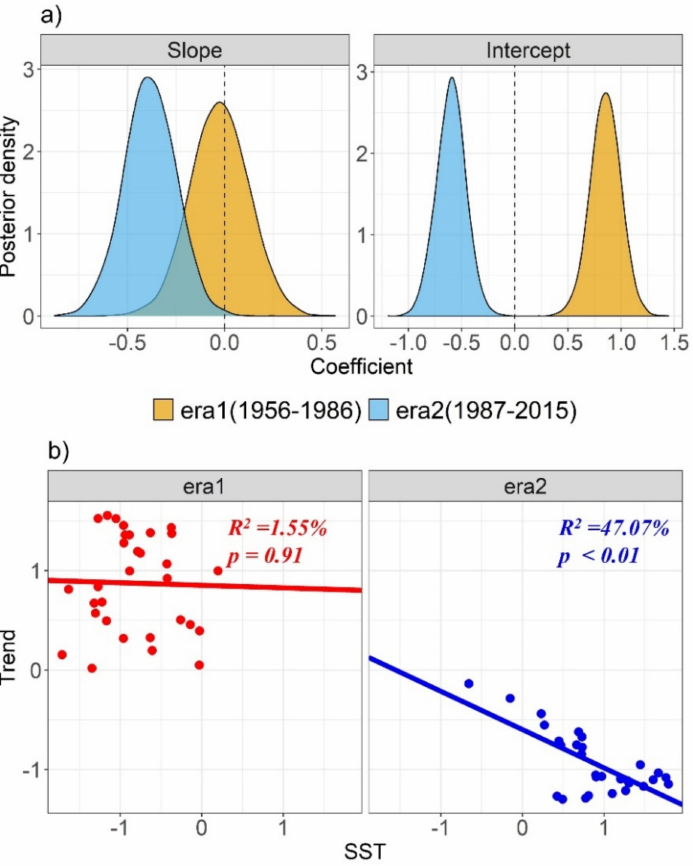
Figure 3. Nonstationary temporal responses of demersal fishes to SST. ( a ) Era-specific posterior distributions of the slope and intercept of the shared trend of the SST PC1. ( b ) Era-specific scatter plots and best linear fittings with the corresponding R 2 and p values estimated by Bayesian regression models.